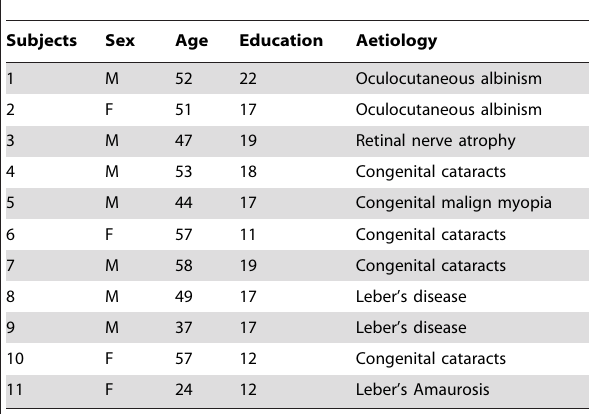
Table 4. Description of BRV subjects (Experiment 2).